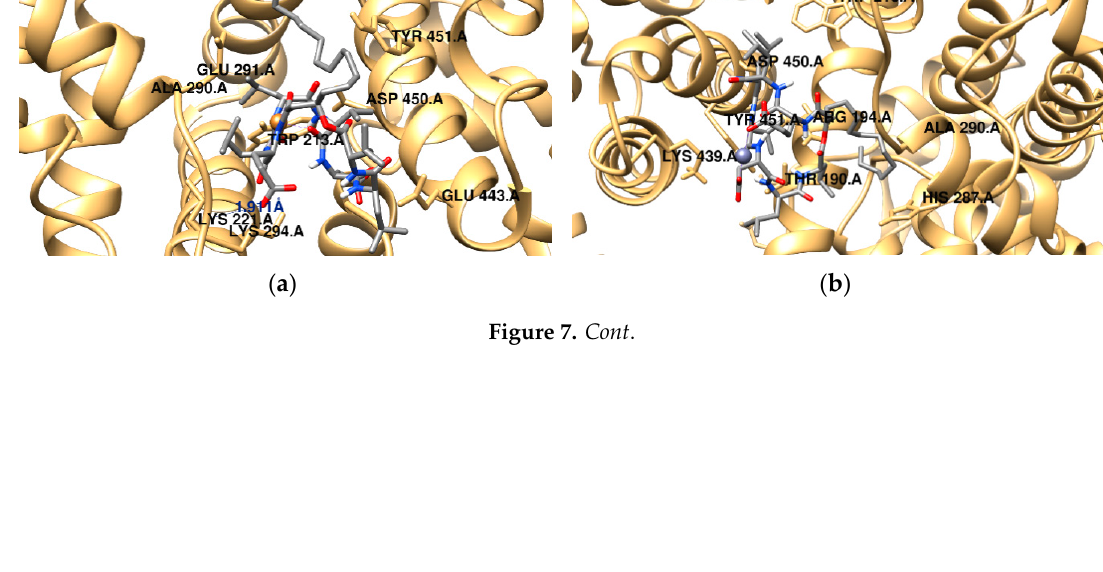
Table 4. Thermodynamic parameters for the binding of surfactin and metal-surfactin complexes to BSA.